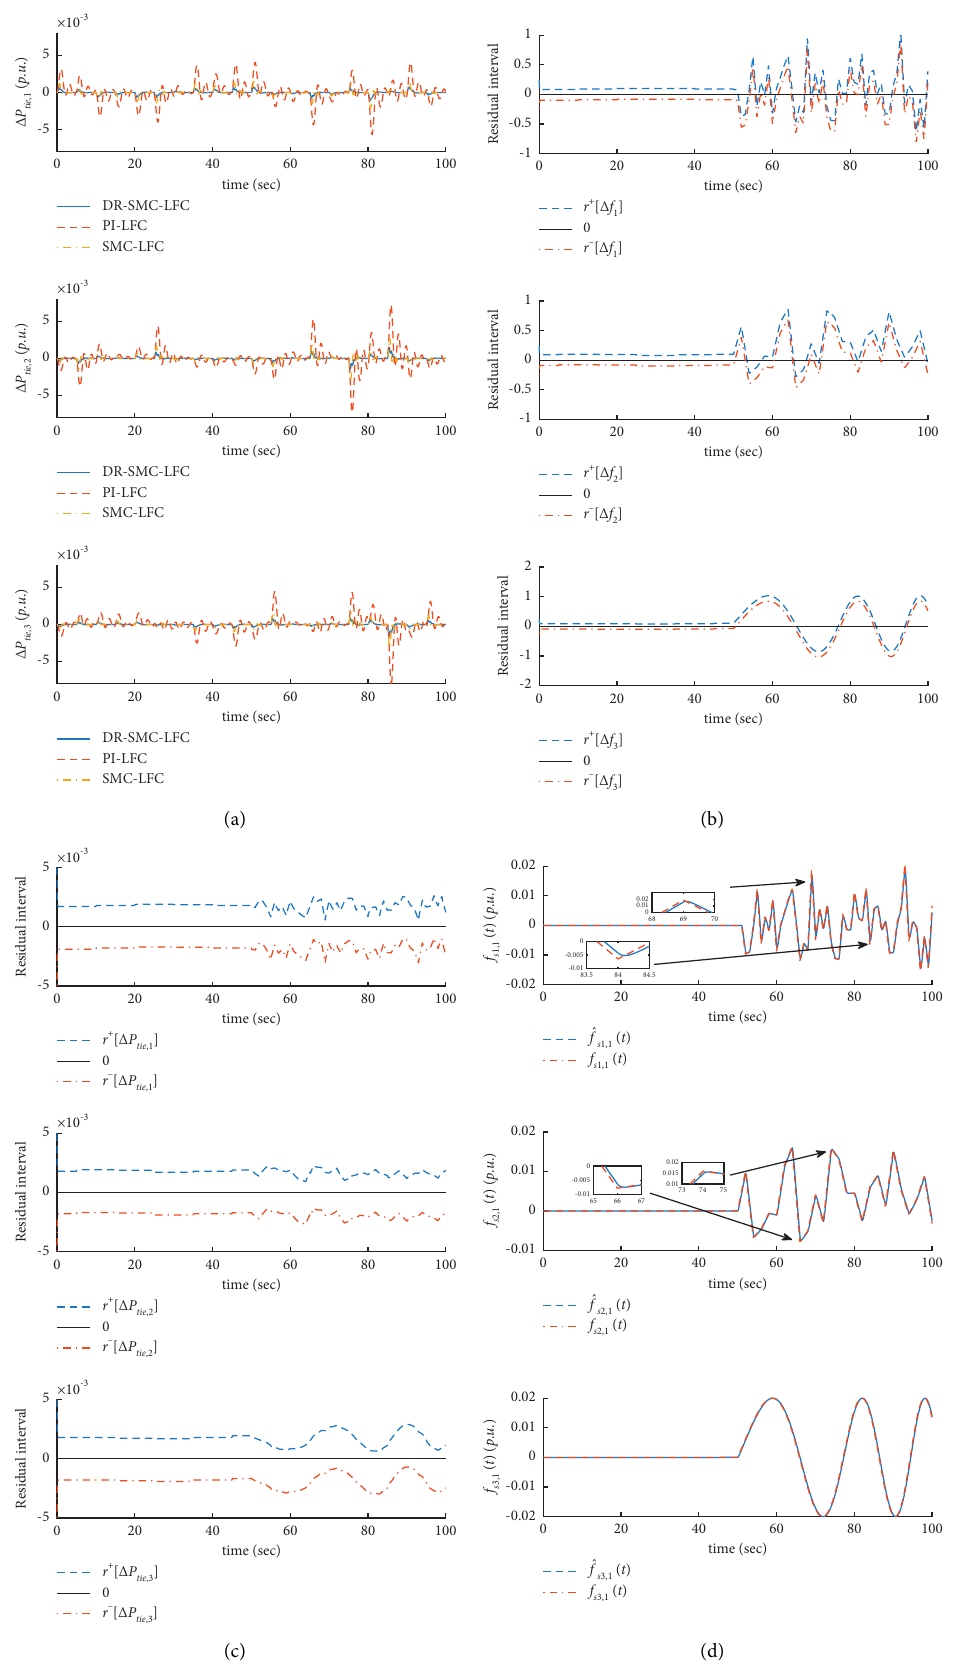
Figure 4: Simulation performance. (a) Δ P ( t ) of each power grid under load disturbance. (b) Interval residual errors of Δ f tie,i power grid. (c) Interval residual errors of Δ P tie,i ( t ) of each power grid. (d) The estimation of f si ( t ) of each power